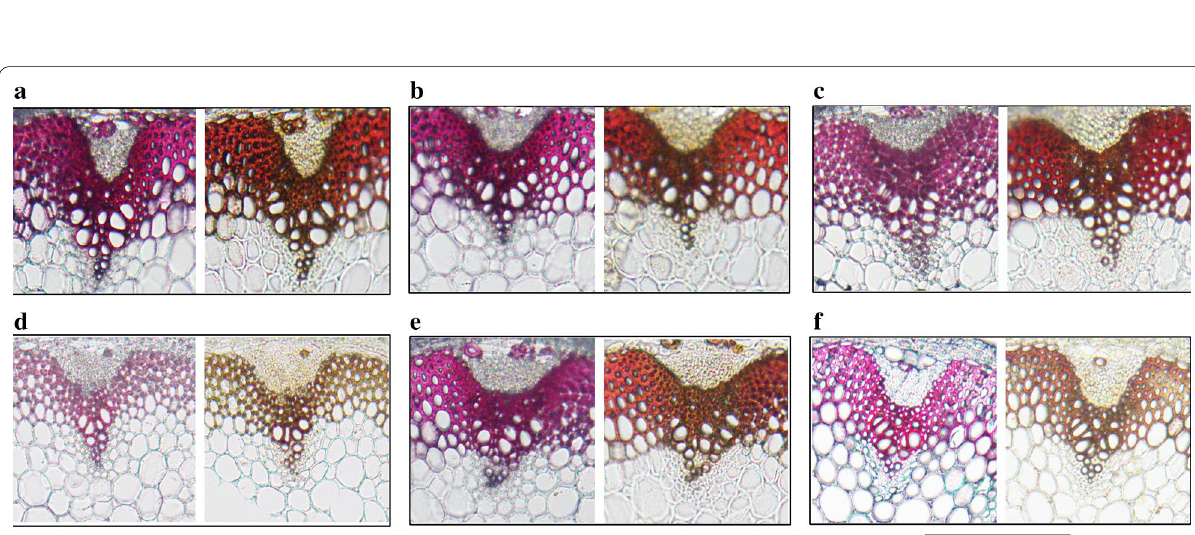
Fig. 5 Stem cross section of representative A. thaliana lines stained by Wiesner (left) and Maule (right) reactions. a WT; b WT - 35S:NcCSE ; c WT - 35S:NcHCT ; d cse ; e cse - 35S:NcCSE ; f c se - 35S:NcHCT ; bar